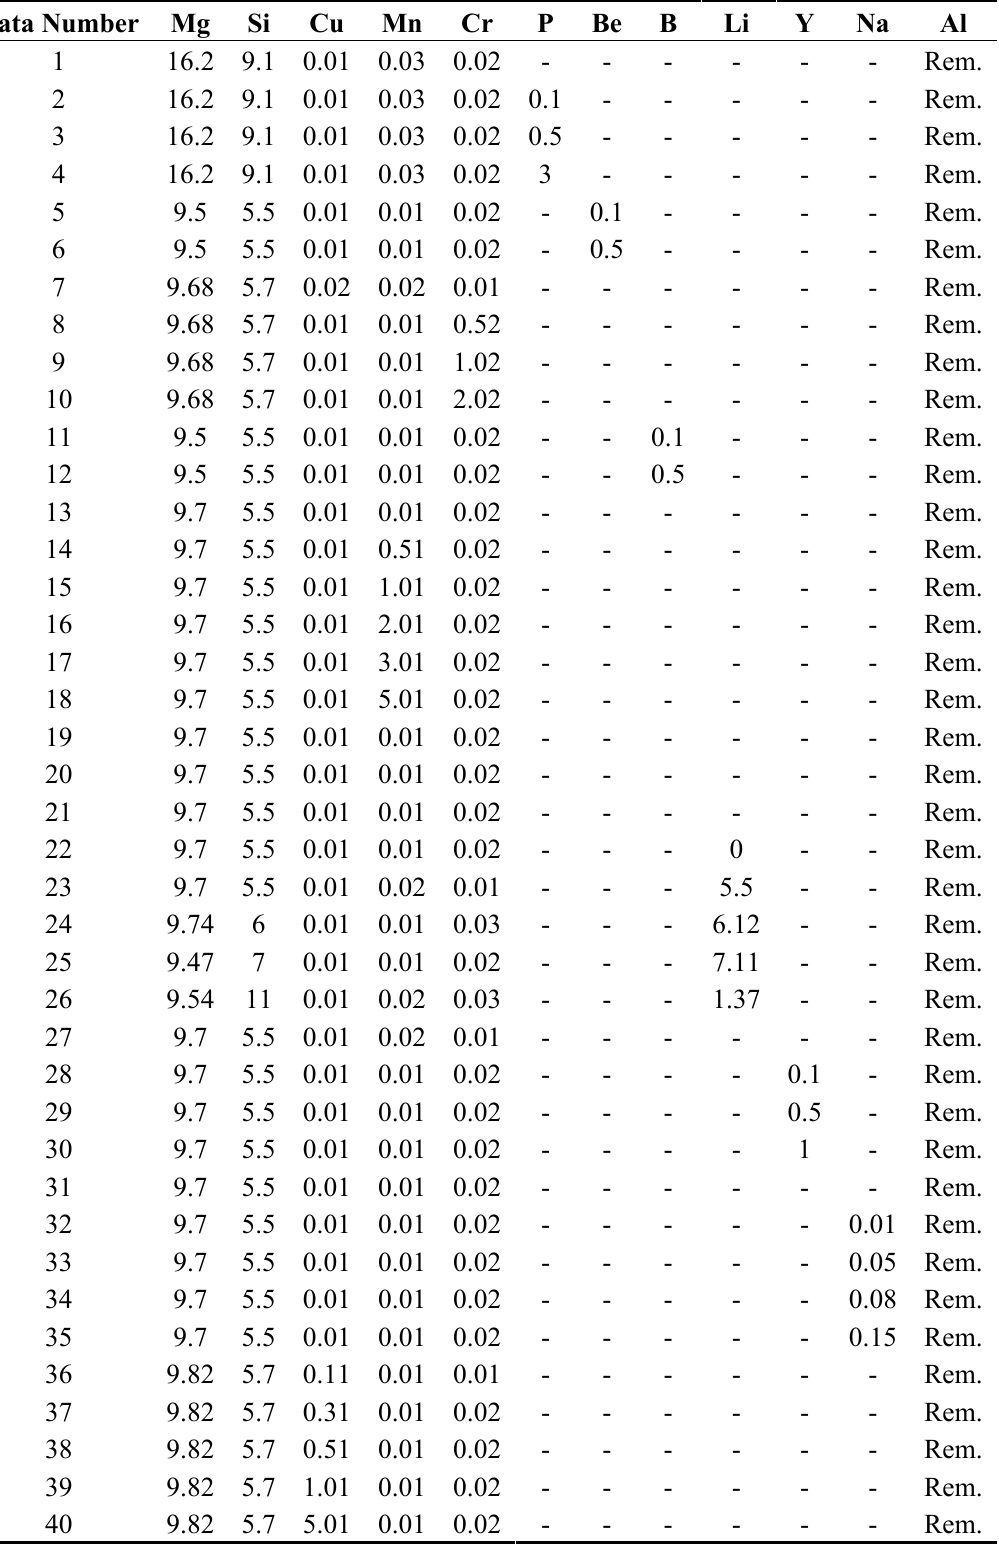
Table 1. Training input data